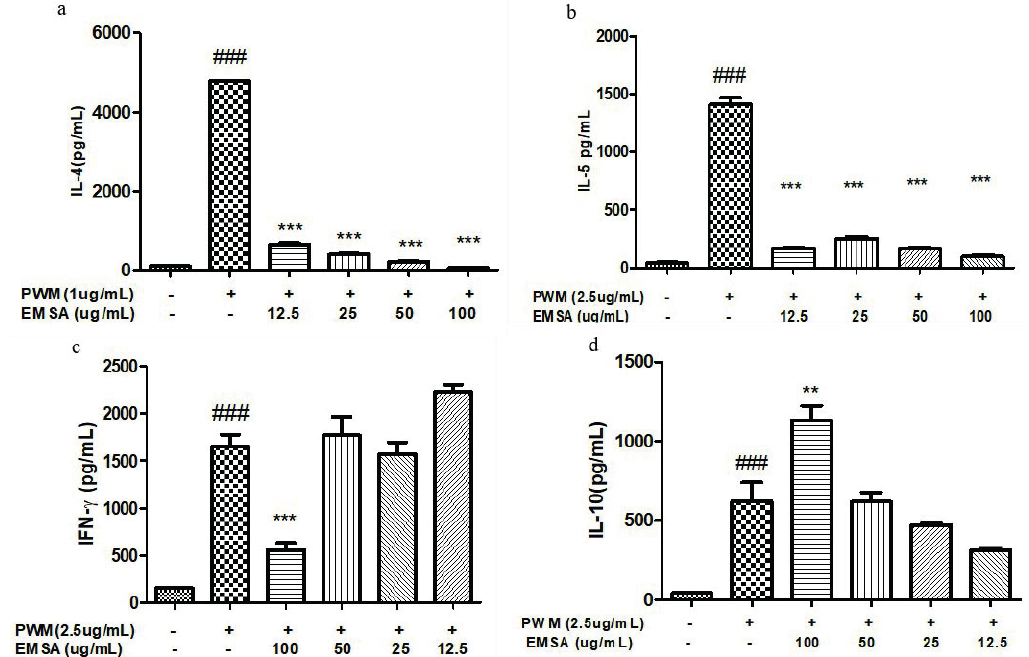
Figure 3 - ( a ) Effect of EMSA on IL-4 production in culture stimulated with PWM. n = 6 (p ### <0.001 vs . Control; *** p<0.001 vs. PWM). ANOVA and Tukey’s tests. ( b ) Effect of EMSA on IL-5 production in culture stimulated with PWM. n = 6 (p ### <0.001 vs. Control; *** p<0.001 vs . PWM). ANOVA and Tukey’s tests. ( c ) Effect of methanol extract of EMSA on the production of IFN-у in culture stimulated with PWM. n = 6 (p ### <0.001 vs . Control; *** p<0.001 vs . PWM). ANOVA and Tukey’s tests. ( d ) Effect of EMSA on the production of IL-10 in culture stimulated with PWM. n = 6 (p ### <0.001 vs. Control. ** p<0.01 vs . PWM). ANOVA and Tukey’s